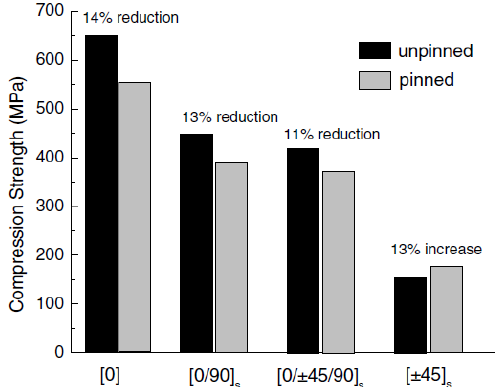
Figure 44. E ff ect of fiber lay-up on compressive modulus due to z-Pinning (CFRP z-Pins, 2.0 vol%, d = 0.51 mm, pre-preg)